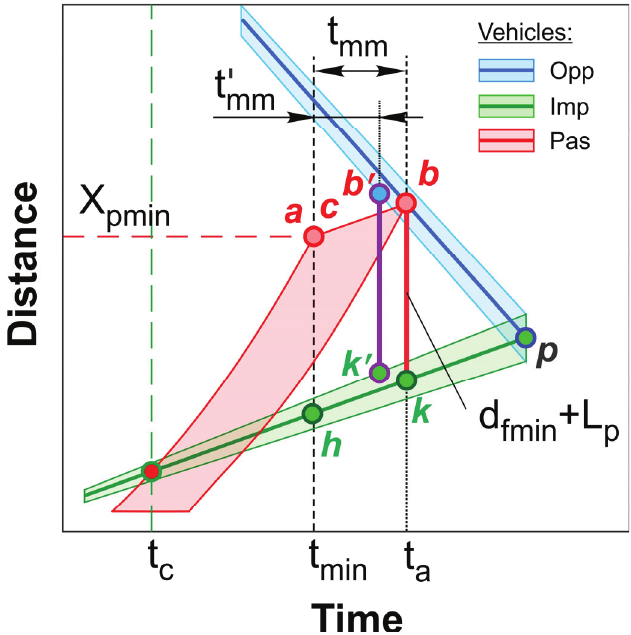
Figure 5. Limiting case of the maximum performance.